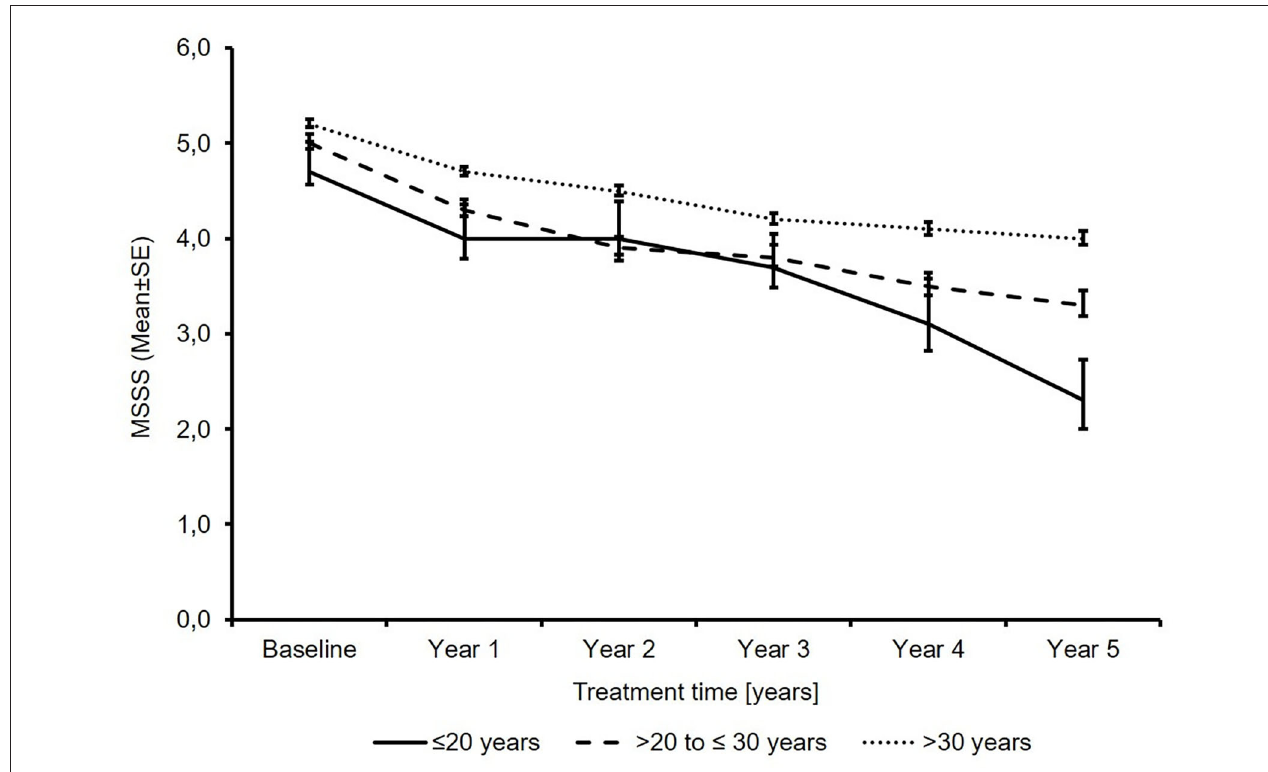
FIGURE 3 | Total multiple sclerosis severity score ( N ′ ≤ 20 years: 71/51/34/26/17/12; N ′ > 20 to ≤ 30 years: 741/525/397/292/239/179; N ′ > 30 years: 2691/1953/1552/1216/1016/775; baseline/year 1/year 2/year 3/year 4/year